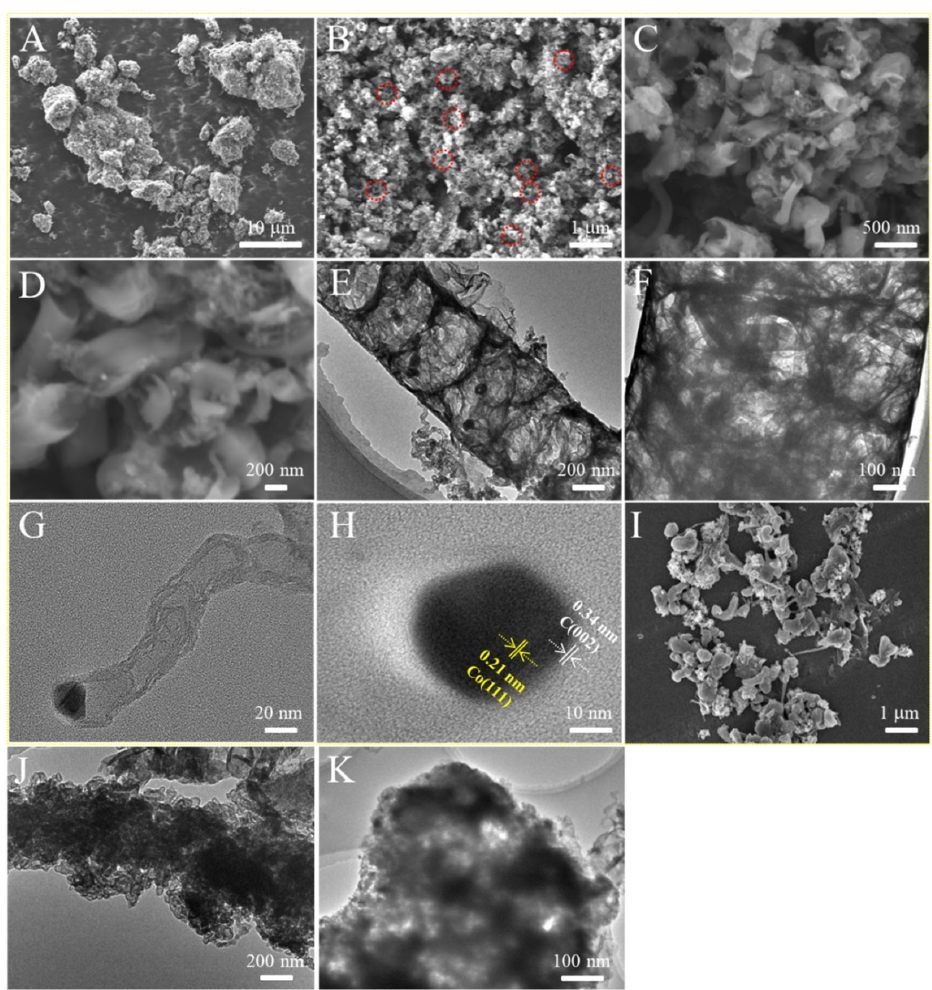
Figure 2. SEM ( A – D ), and corresponding TEM images ( E – H ) of Co@NCNTs 1 catalyst sample prepared in the presence of CaCl 2 . SEM ( I ), and TEM ( J , K ) images showing the Co@NCNTs 2 catalyst sample prepared in the absence of CaCl 2 .